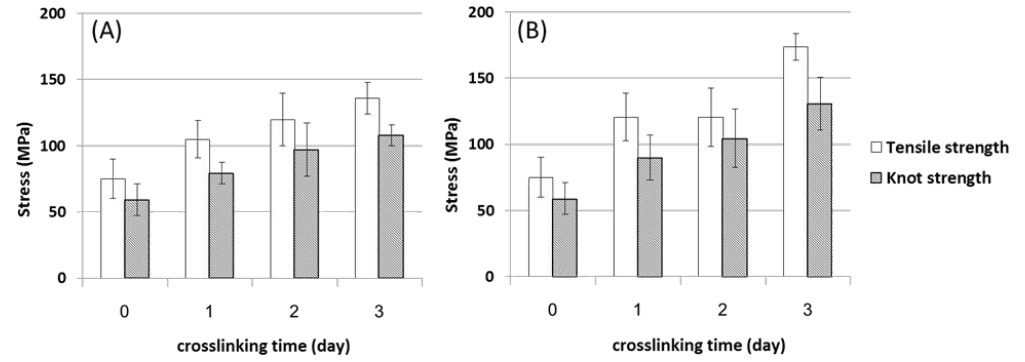
Figure 6. Mechanical strengths of GTA-treated gelatin fibers: ( A ) no heat treatment and ( B ) heat treatment at 100 °C for 24 h.